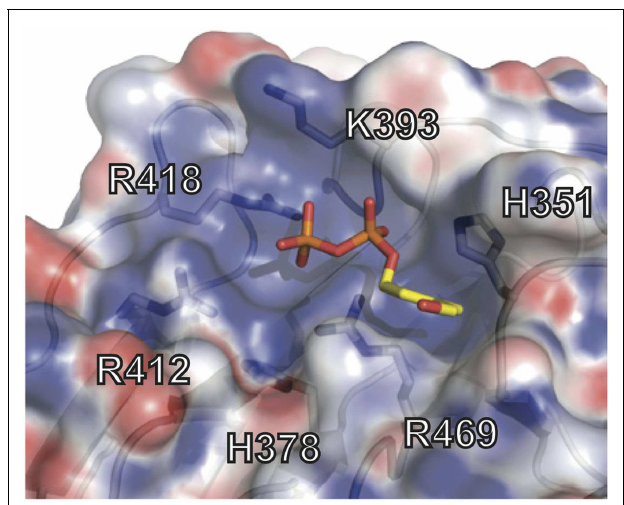
FIGURE 7 | Phosphoantigen binding pocket of B30.2 domain . Close-up view of the B30.2 pAg binding pocket with the side chains lining the pocket shown under the semi-transparent surface.The positions are labeled with the numbering relative to the full-length BTN3A1 molecule.The pAg is shown as sticks, modeled into the binding pocket; phosphates are colored orange and red (oxygen) and the organic moiety is shown in